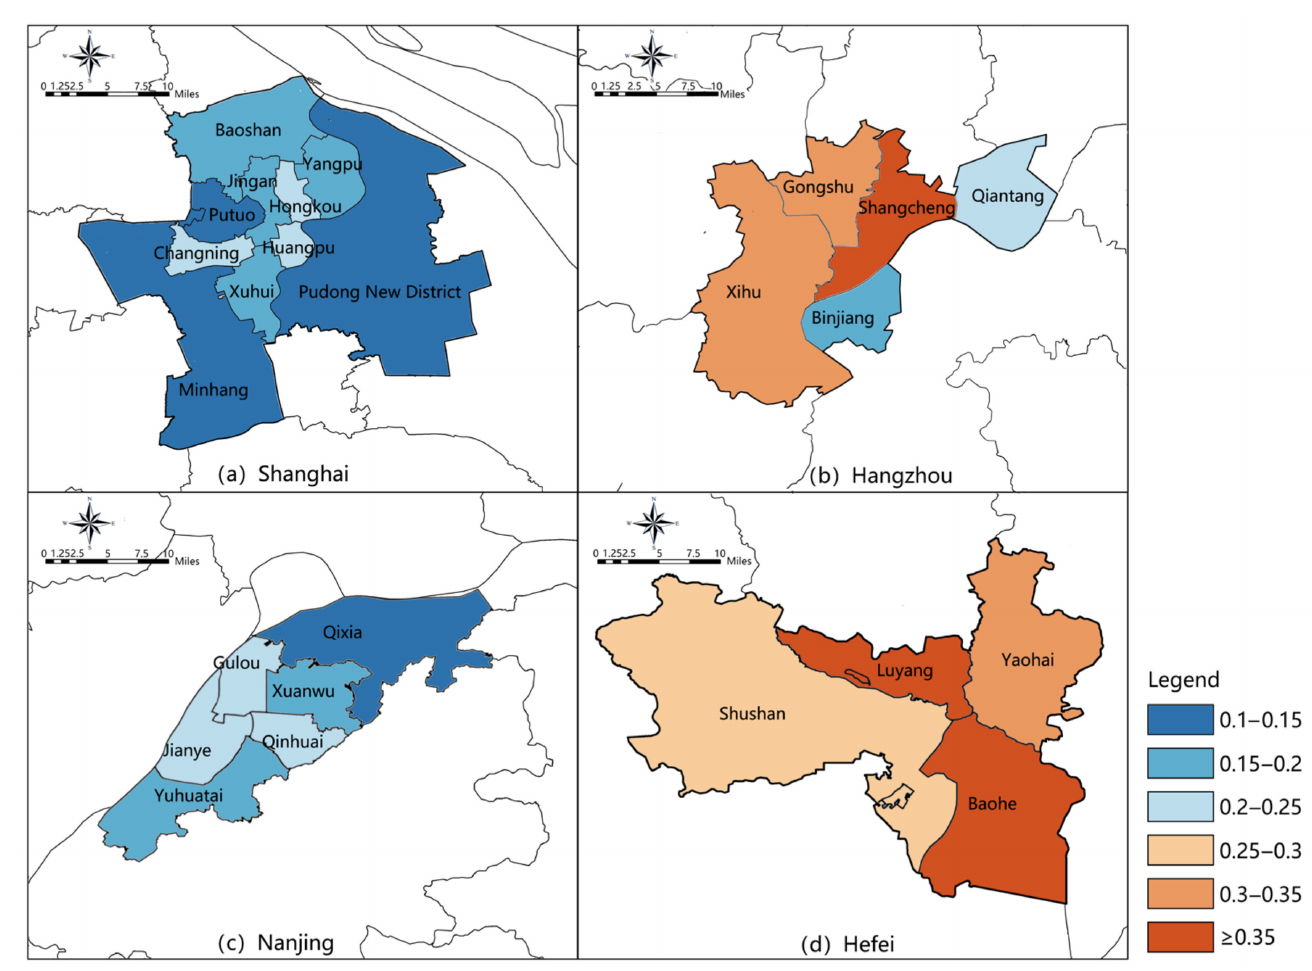
Figure 4. The CLI distribution of the administrative districts in the main urban areas of the four central cities in the